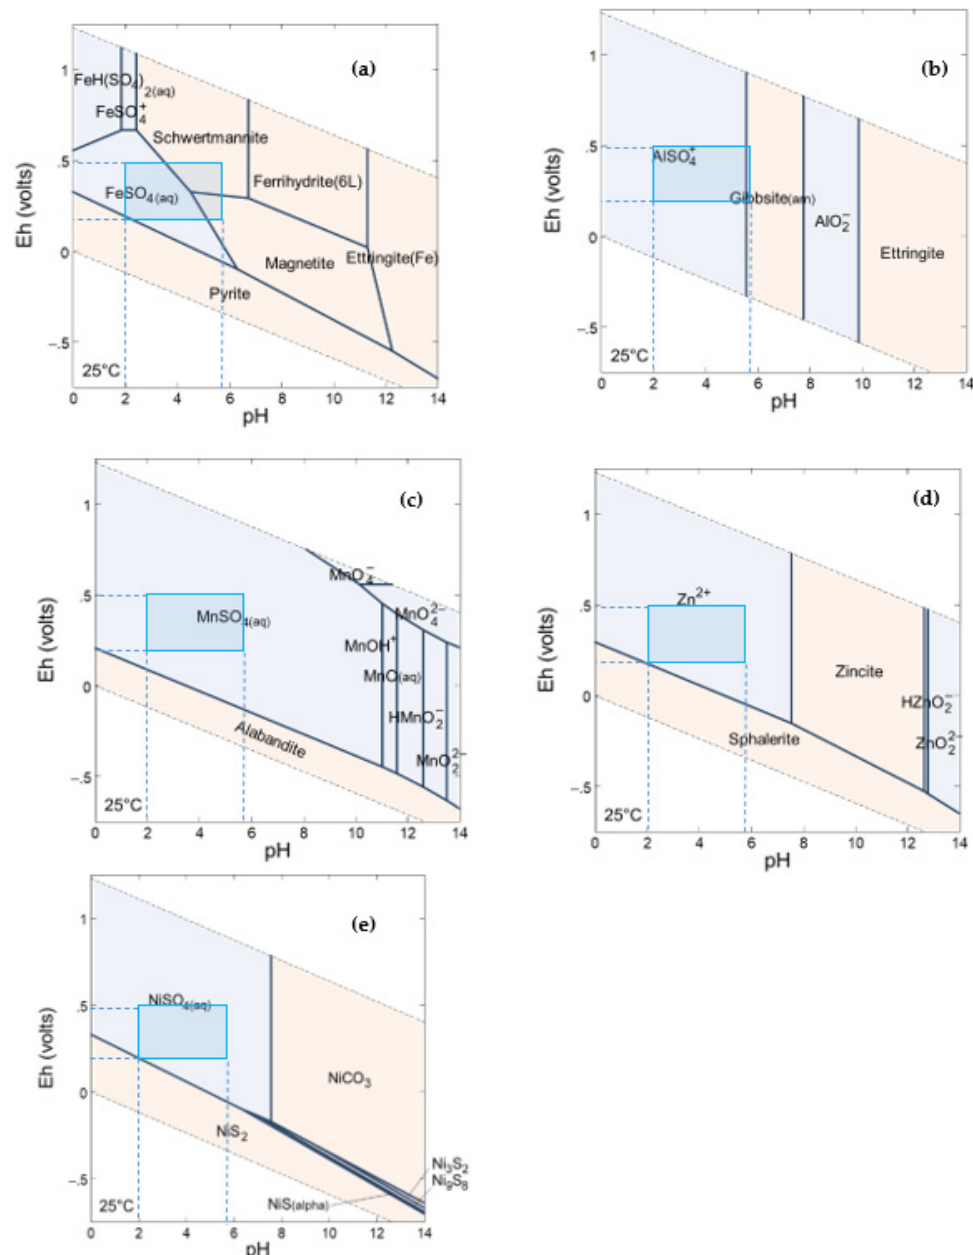
Figure 7. Eh-pH predominance diagram of ( a ) Fe 3+ (activity = 10 − 2.65 ), ( b ) Al 3+ (activity = 10 − 4.53 ), ( c ) Mn 2+ (activity = 10 − 3.99), ( d ) Zn 2+ (activity = 10 − 3.9), and ( e ) of Ni 2+ (activity = 10 − 3.7) at 25 °C, 1.013 bars and activities of SO 42 − , Na + and Ca 2+ equal to 10 − 1.6 , 10 − 0.57 and 10 − 2.4 , respectively. Carbonate was modelled in the system by equilibrating it with the average CO 2 in air (Fugacity = 10 –3.5 ). The dashed rectangle refers to experimental conditions in this study.